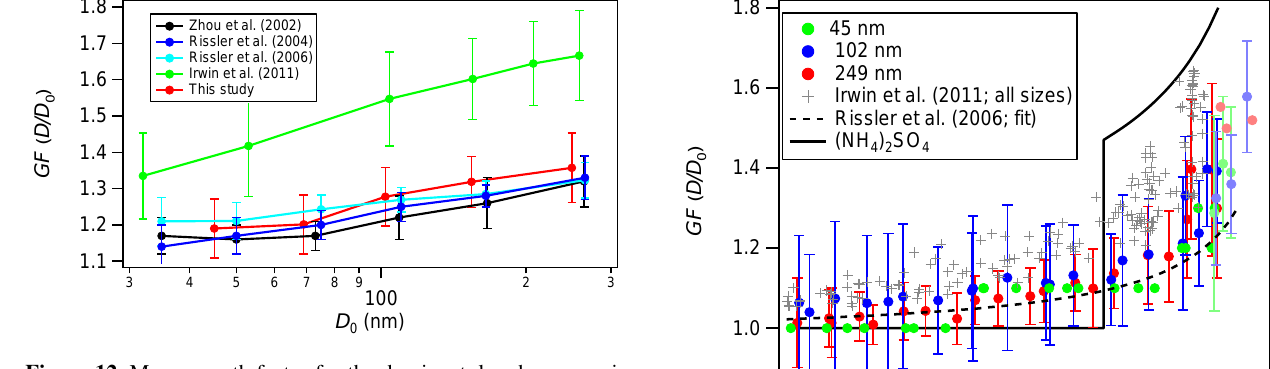
Figure 12. Mean growth factor for the dominant, less hygroscopic mode plotted against dry diameter, comparing this to previous stud- ies in Amazonia and Borneo. The data from Rissler et al. (2004) and Rissler et al. (2006) represent less hygroscopic and moderately hygroscopic particles (respectively) during the wet season. The def- initions differ slightly between the studies in terms of GF range, but the modes represented here broadly fit into the less hygroscopic classification of Swietlicki et al. (2008). Error bars represent ± 1 standard deviation.